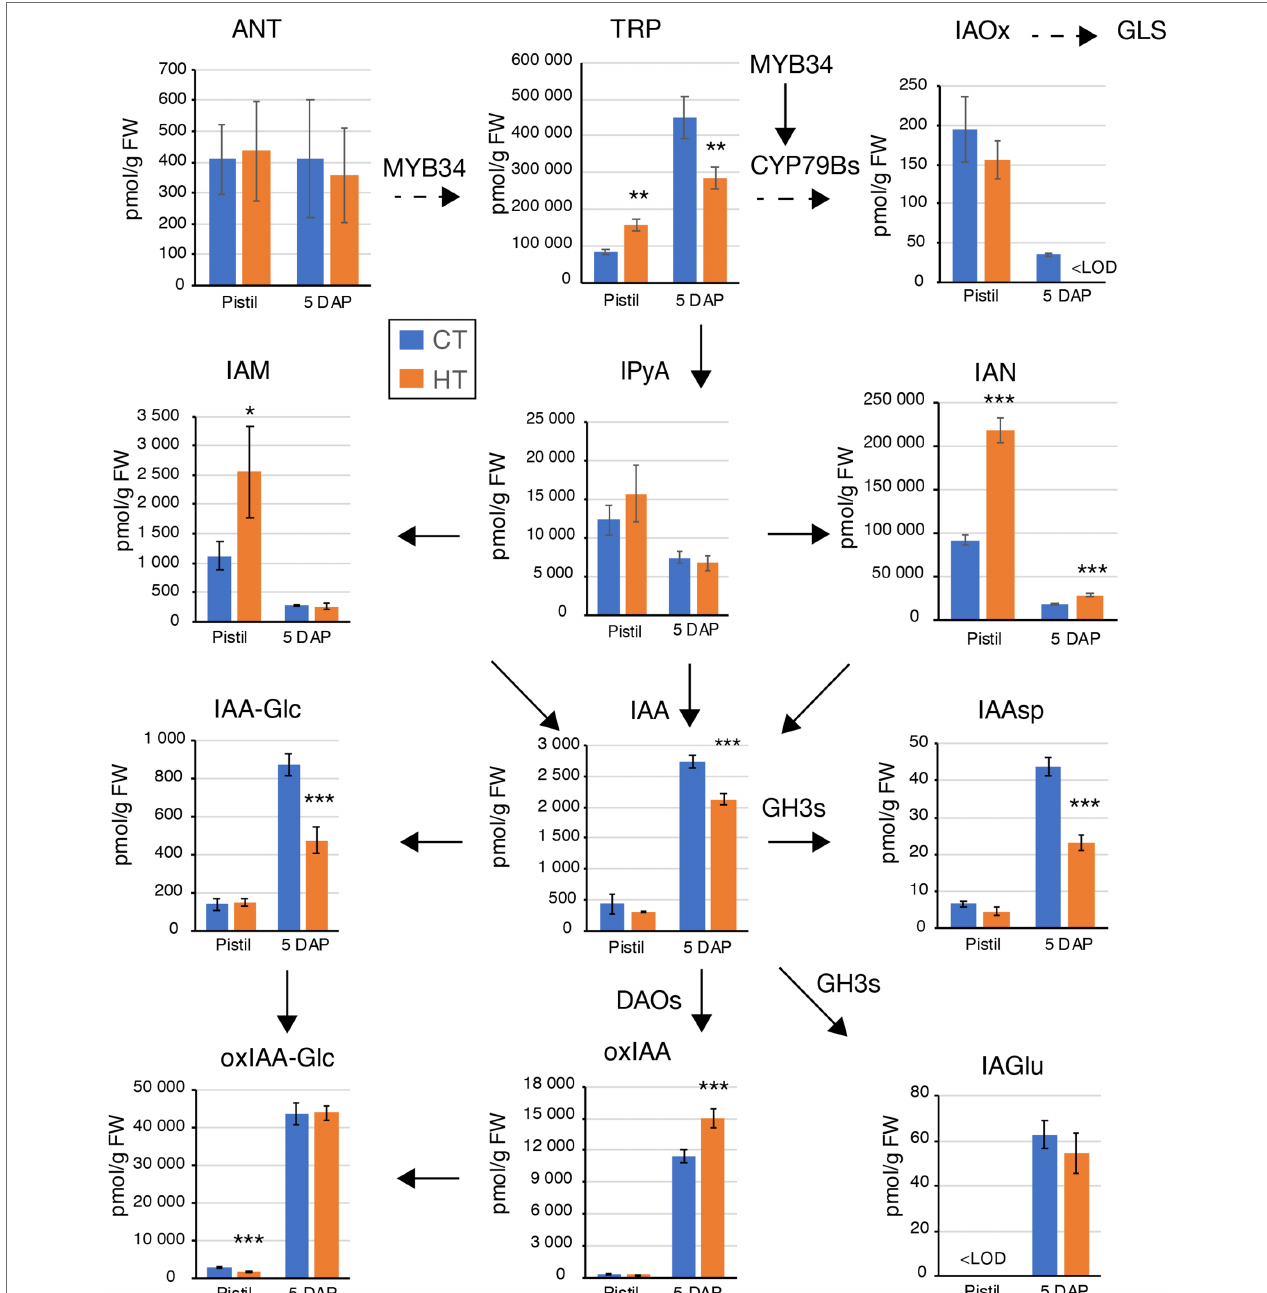
FIGURE 2 | Differences in auxin and auxin metabolites levels induced by high temperatures in Westar pistils and 5 days after pollination (DAP) seeds. Graphs displaying the levels (pmol/g FW) of anthranilate (ANT), tryptophan (TRP), indole-3-acetaldoxime (IAOx), indole-3-pyruvic acid (IPyA), indole-3-acetamide (IAM), indole-3-acetonitrile (IAN), indole-3-acetic acid (IAA), IAA-glucose (IAA-Glc), IAA-aspartate (IAAsp), IAA-glutamate (IAGlu), 2-oxoindole-3-acetic acid (oxIAA), and oxIAA-glucose (oxIAA-Glc). Measurements were done in two biological replicates, five technical replicates in Westar pistils and 5 DAP seeds from plants grown at CT (blue) and HT (orange). Shown is the average ± SD of one of the two biological replicates. <LOD, below the limit of detection. Asterisks indicate statistically significant difference in HT in a paired Student’s t -test ( t -test; *, **, and *** correspond to value of p 0.05 > p > 0.01, 0.01 > p > 0.001, and p < 0.001, respectively). Arrows indicate the direction of the biosynthesis pathway (plain arrow, direct reaction; dashed arrow, multiple-step enzymatic reactions). The names closed to the arrows indicate the enzymes involved in the reactions and whose gene expression was tested in Figure 3 . Source data are shown in Supplementary Table S3